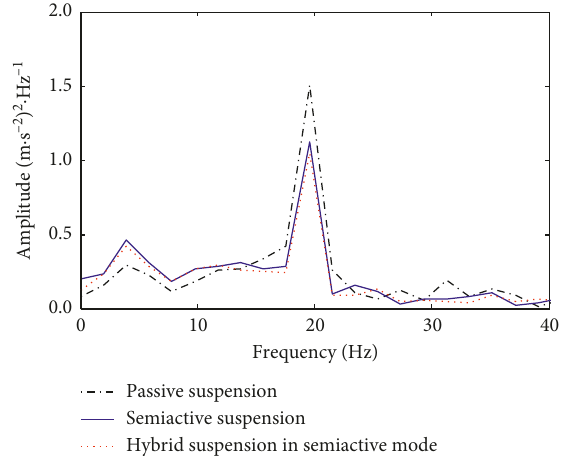
Figure 24: The dynamic response of the sprung mass acceleration of the hybrid suspension in active mode.